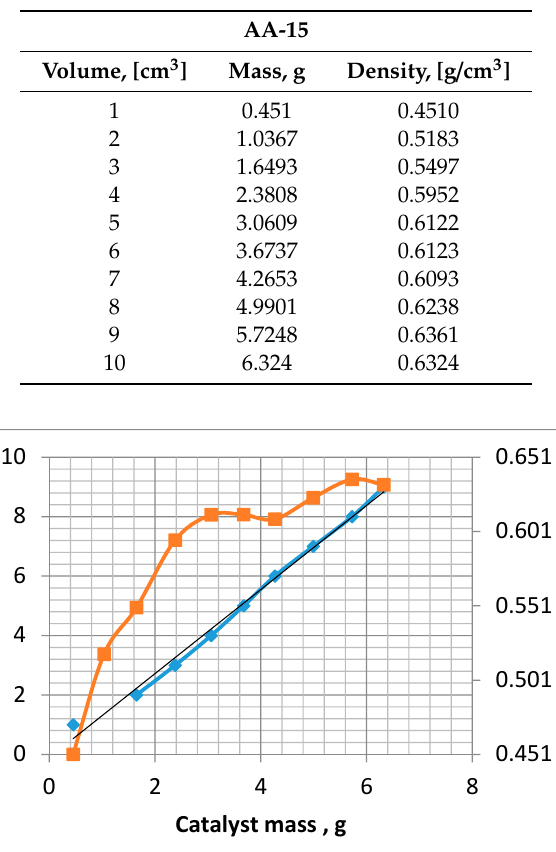
Table 19. Apparent Density of the Packed Catalytic bed.